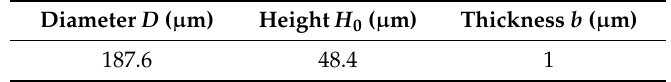
Table 1. The structural parameters of the bionic model of the tympanic